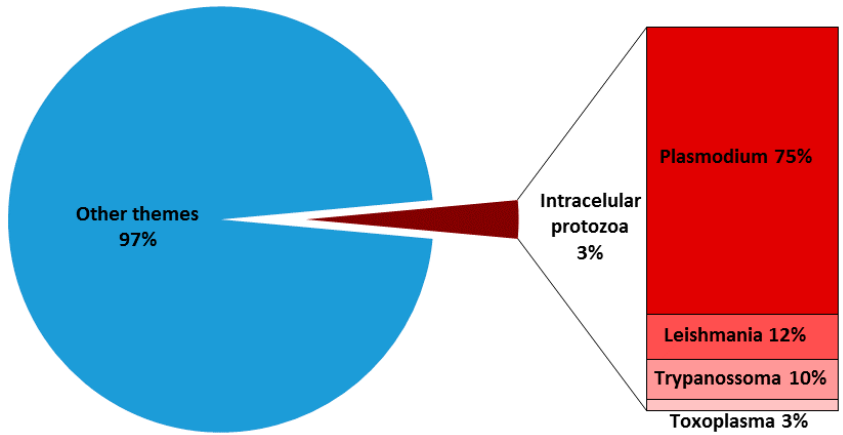
Figure 4. Prevalence of Elispot indexed (PubMed) articles in tropical diseases caused by intracellular protozoa in relation to overall Elispot articles published until June 2017.